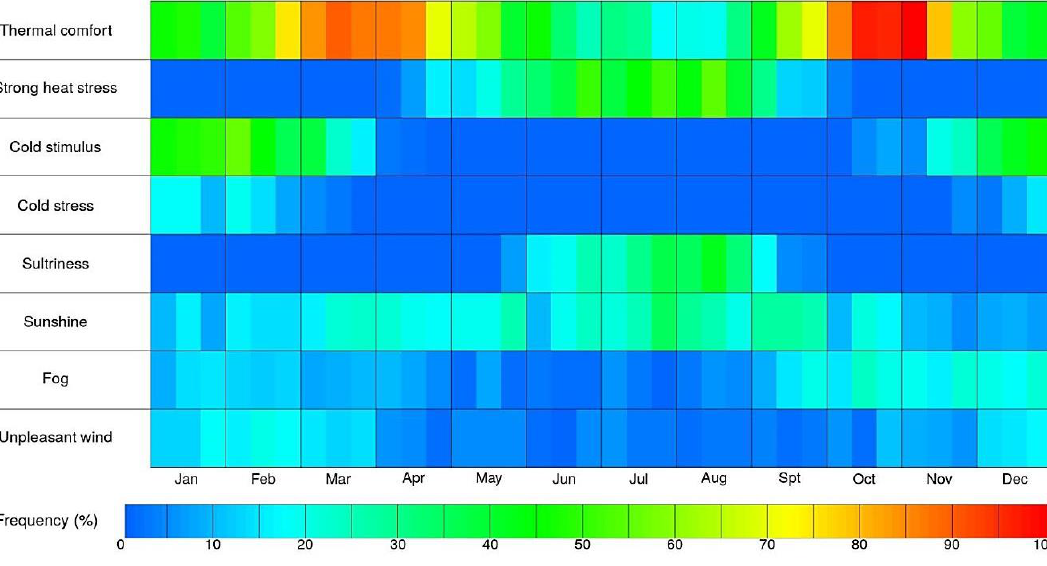
Figure 7. CTIS of the city of Freiburg, extracted from the AOI of southern Baden, averaged over the time period 1995–2012 (6–18 UTC).